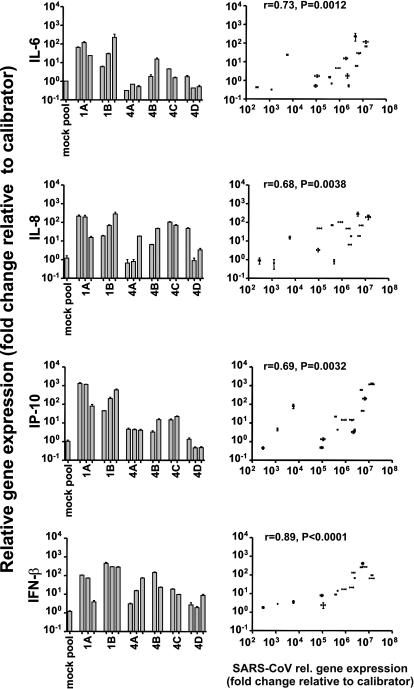
Confirmation of Microarray Results with RT-PCR and Correlation of Induced Genes with Presence of SARS-CoVQuantitative RT-PCR for IL-6, IL-8, CXCL10 (IP-10), and IFN-β was performed on all separate lung samples. Expression levels of these genes were plotted against the presence of SARS-CoV in these samples (as detected by RT-PCR). Correlation coefficients were determined using Spearman's correlation test.